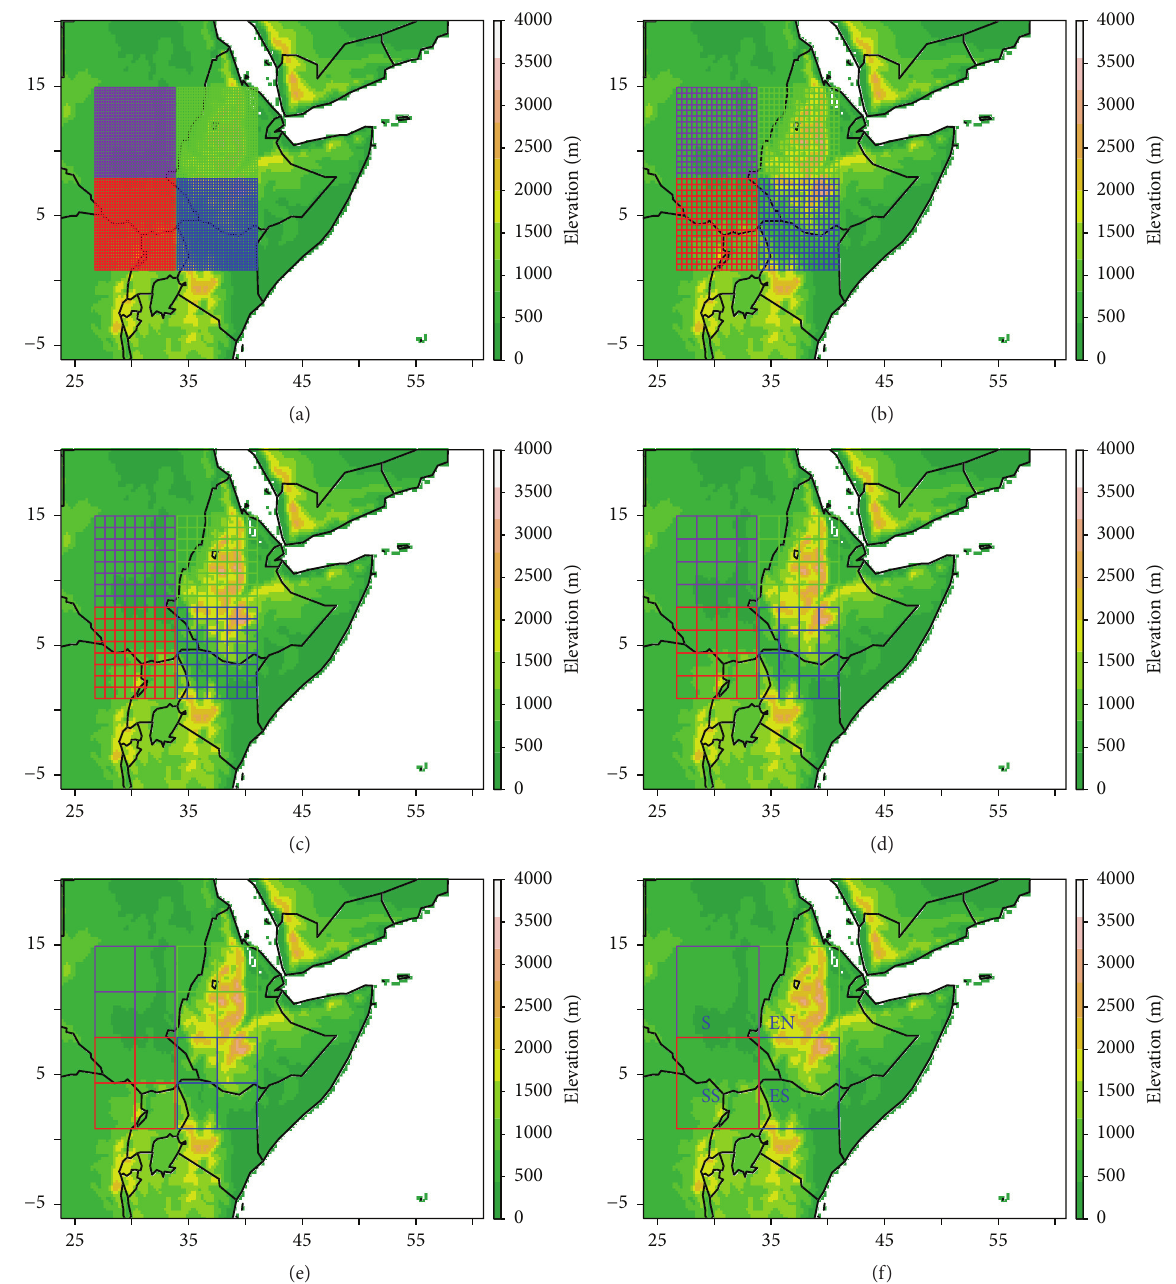
Figure 1: Simulation domain over East Africa, where the colour scale shows the elevation (m) over the entire region. The boxes represent the four investigated subregions: North Ethiopia (EN: green), South Ethiopia (ES: blue), South Sudan (SS: red), and Sudan (S: purple). The different panels show the representation of the grid in each region for the calculation of potential and relative potential added value: (a) original 0.22 ∘ , (b) 0.44 ∘ , (c) 0.88 ∘ , (d) 1.76 ∘ , (e) 3.72 ∘ , and (f) 7.04 ∘